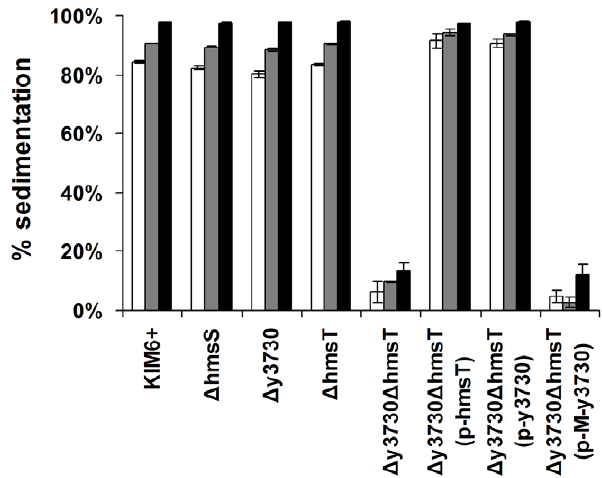
Figure 5. y3730 and hmsT are required for Y.pestis autoag- gregation. The % sedimentation of bacterial growth in liquid cultures was determined by spectrophotometry after 1, 2, and 12 hours of stasis (white, grey, and black bars, respectively). The mean and SD of two independent experiments performed in duplicate are indicated.